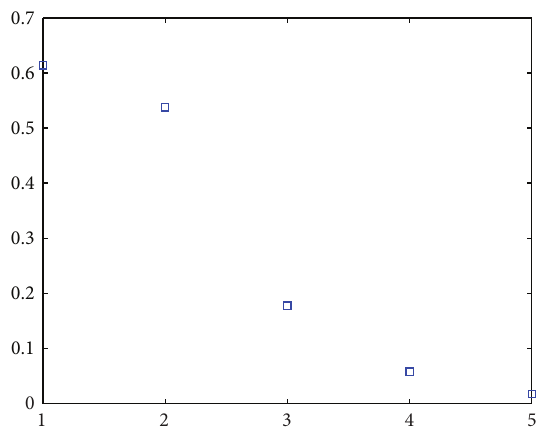
Figure 4: Error of two probabilities with ratio <